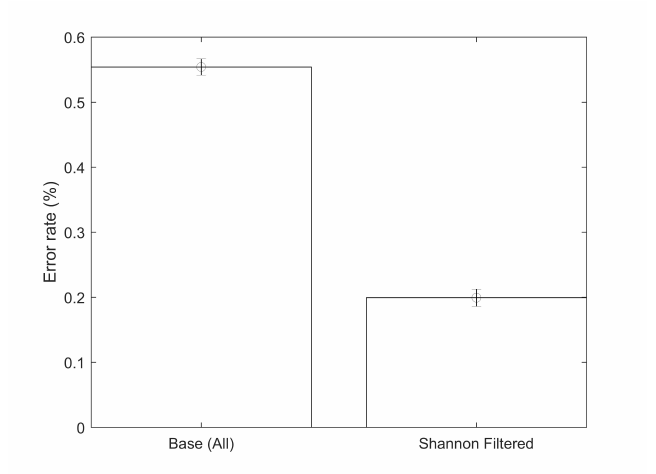
Figure 4. Error rate comparison between direct approach and Shannon Entropy filtered